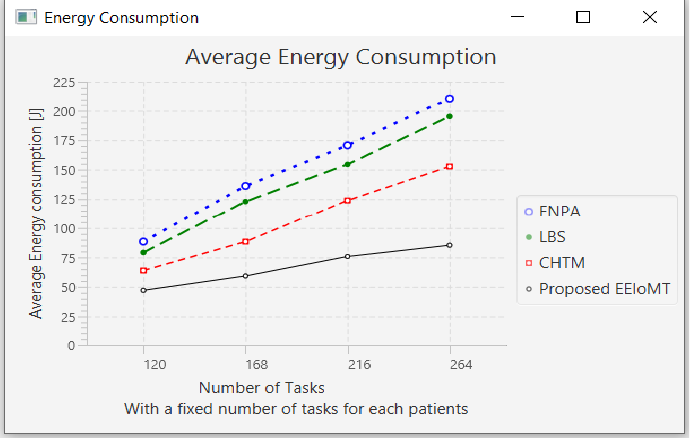
Figure 21. Average energy consumption comparison when changing the number of tasks.